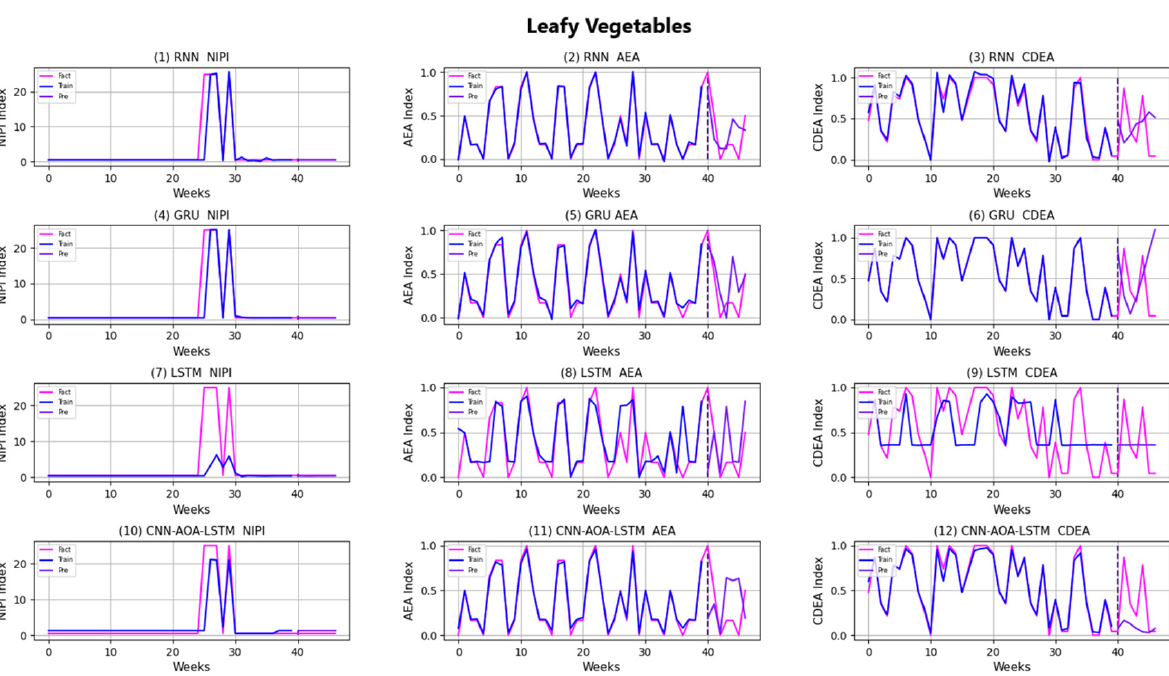
Figure 9. Prediction results of indexes of leafy vegetables. After predicting NIPI, AEA and CDEA evaluation indexes, the distance between risk evaluation indexes and security risk levels is calculated, and the security risk level is determined. The average accuracy of the prediction results of the four models is statistically analyzed, as shown in Table